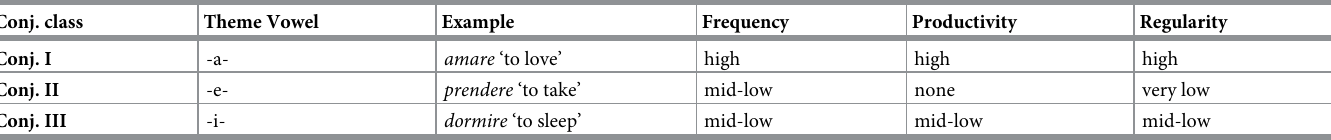
Table 2. Italian verb conjugation